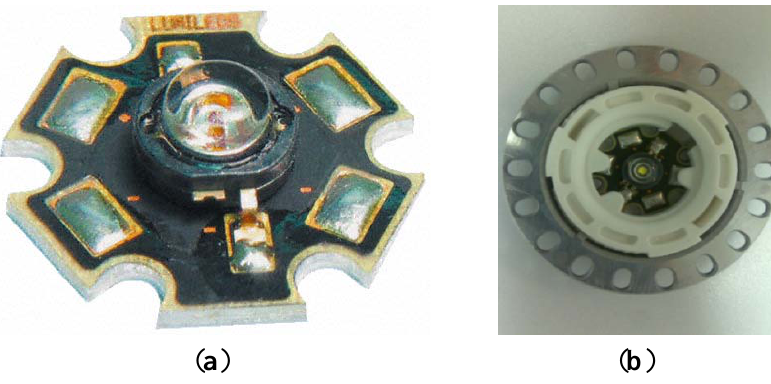
Figure 6. ( a ) Luxeon star LED from Philips; ( b ) Luxeon star LED with holder.